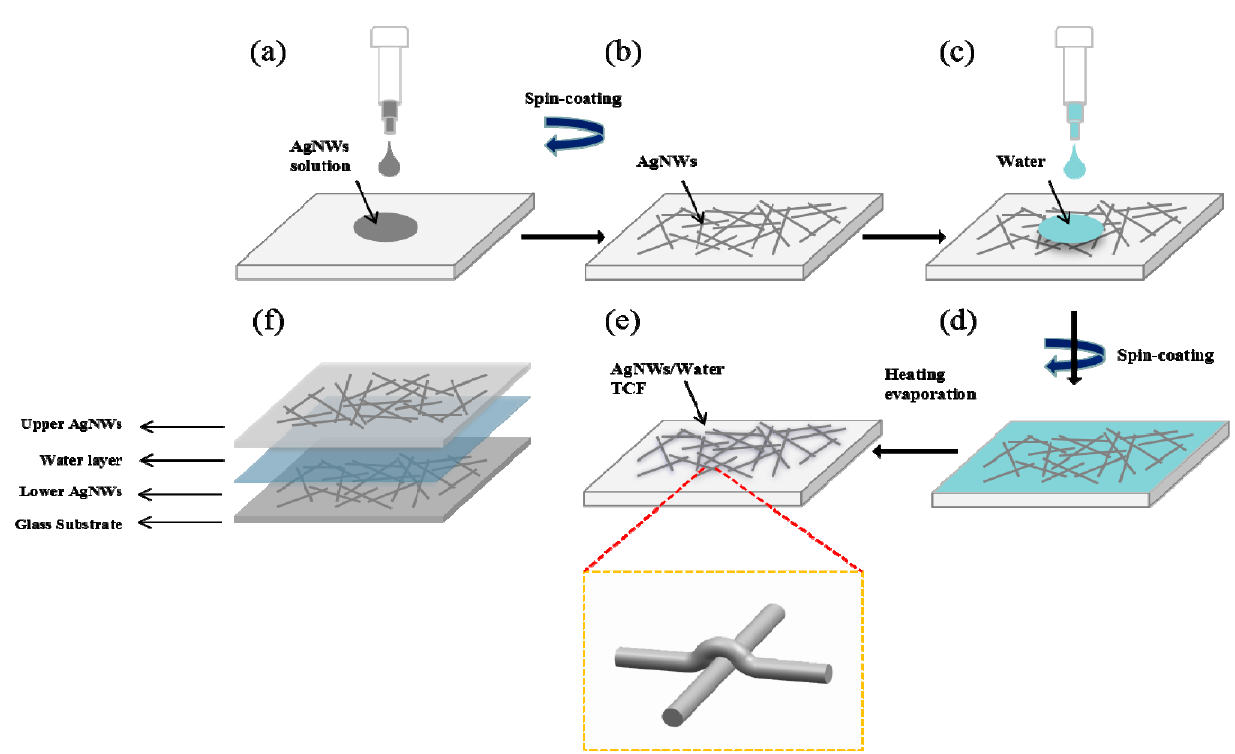
Figure 1. AgNWs-Moisture-AgNWs treatment scheme diagram of AgNWs-TCF. ( a ) AgNWss solution was dropped; ( b ) spin-coating deposition; ( c ) deionized water was dropped; ( d ) spin-coating deposition and heating; ( e ) AgNWs/Water TCF after Water moisture treatment; ( f ) layers structure of thin films.